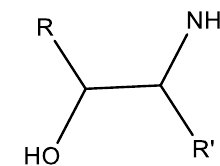
Figure 2. Surface morphology of Os – HTlc ( a ) and EDX mapping of Os in the Os – HTlc catalyst ( b ).